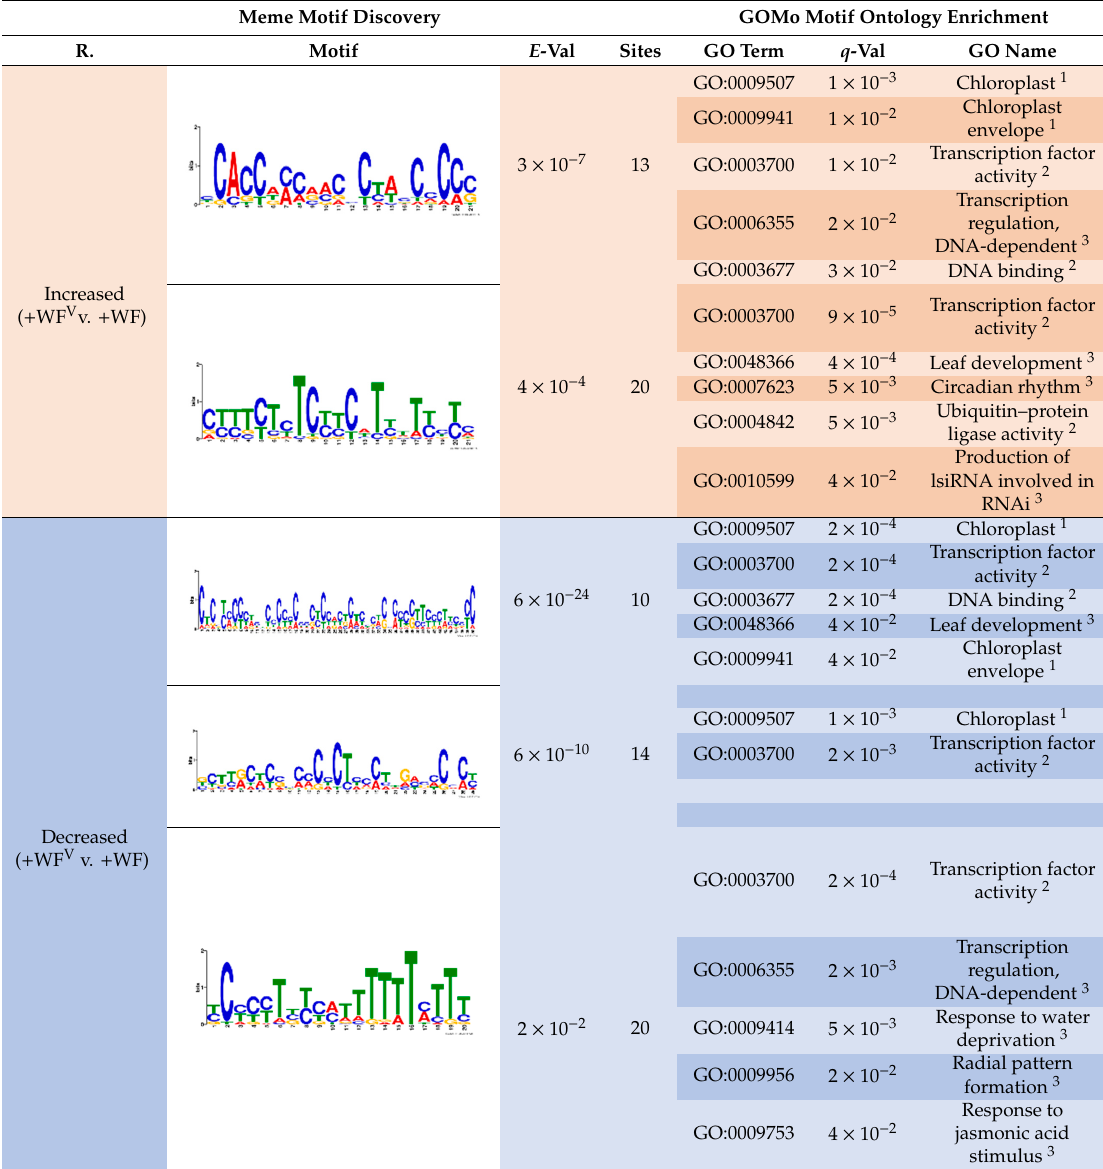
Table 2. Motif discovery and ontology enrichment analysis of similar motifs upstream of genes in Arabidopsis. Meme Motif Discovery GOMo Motif Ontology Enrichment